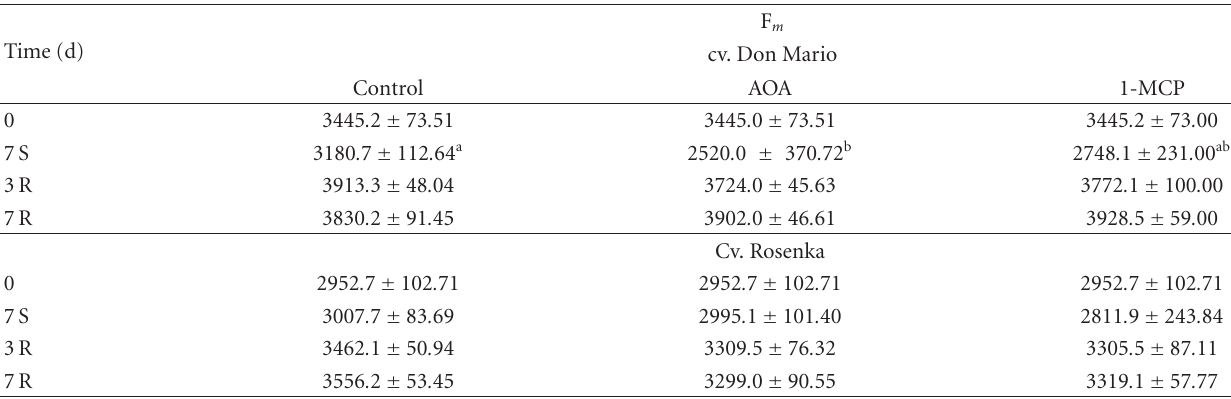
Table 2: F m measured from leaves of two Bougainvillea cultivars stored for 7 days (7S) at 14 ◦ C and transferred at 20 ◦ C for recovery evaluation after 3 and 7 days (3R and 7R).